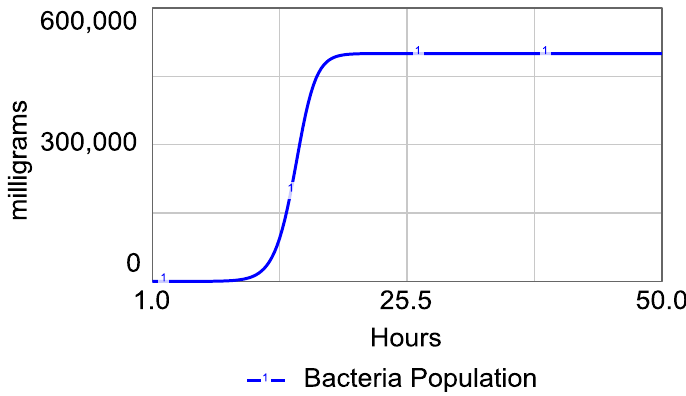
Fig. 25. Stella model output for bacteria